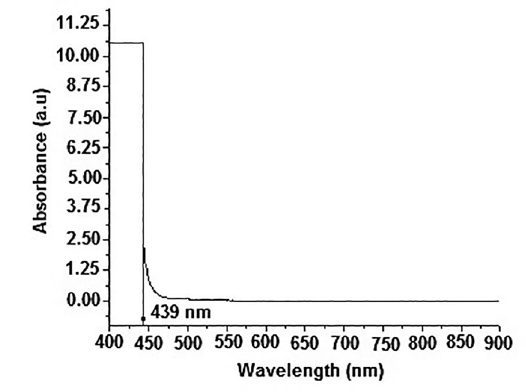
Figure 4: UV-visible absorption spectrum of 4BPTS